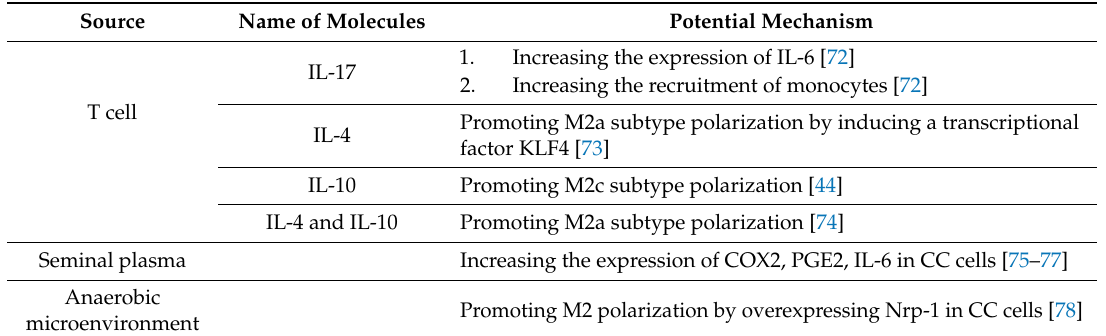
Table 3. Other molecules acting in the formation of TAMs in